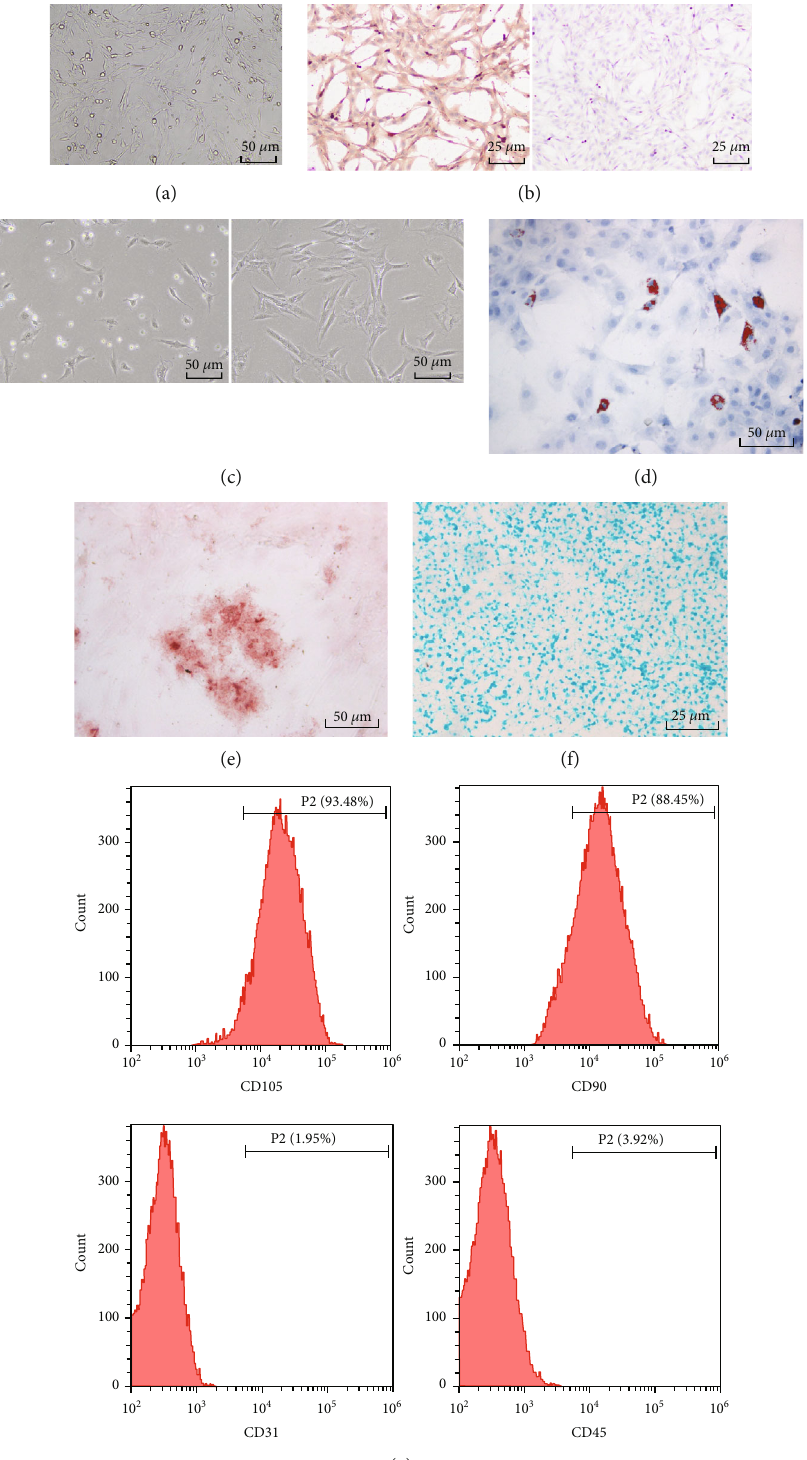
Figure 1: fBMFs and ADSCs are successfully obtained. The obtained fBMFs and ADSCs were identi fi ed. (a) The morphology of primary fBMFs was observed on the 5 th day under the microscope. (b) The expression of Vimentin and pan-CK was detected using immunohistochemistry. (c) The morphology of ADSCs was observed on the 3 rd and 8 th days of culture. (d) The adipogenic ability of ADSCs was detected using oil red O staining. (e) The osteogenic ability of ADSCs was detected using alizarin red staining. (f) The chondrogenic ability of ADSCs was detected using alcian blue glacial acetic acid staining. (g) The expression of CD105, CD90, CD45 and CD31 on the surface of ADSCs was detected using fl ow